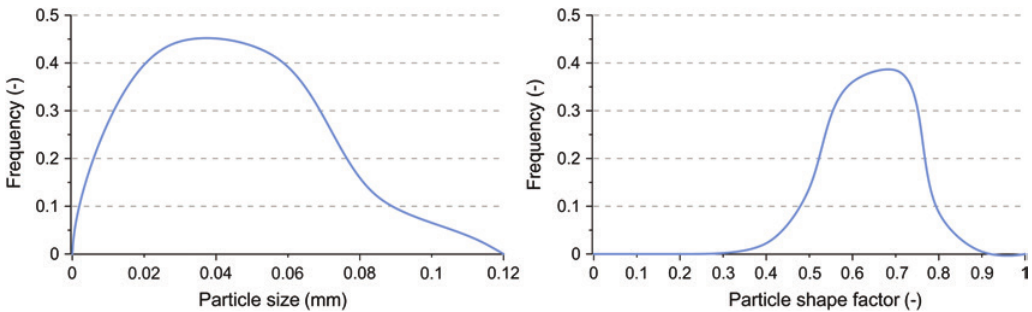
Figure 12: Gypsum particle analysis.